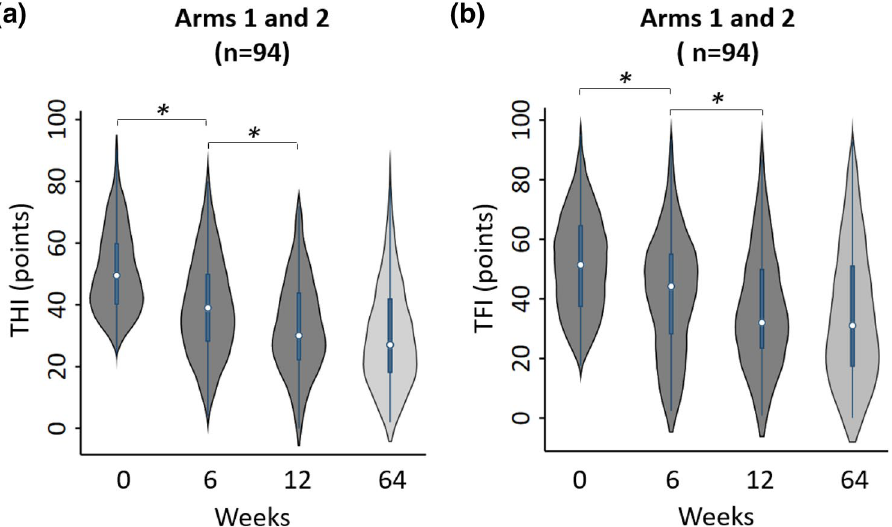
Figure 5. Additional reduction in tinnitus symptoms with adjustment of parameter settings at the midway point during treatment. Absolute THI or TFI scores (distribution of values as violin plots) are presented at different time points during the treatment period at Week 0 (baseline), Week 6 (interim), Week 12 (final) and Week 64 (12-month post-treatment) for pooled data across arm 1 and arm 2 for THI ( a ) and TFI ( b ). Data is included for participants who were treatment-compliant (≥ 18 h treatment at interim and ≥ 36 h treatment at final) and correspond to the same data shown in Fig. 4. Different stimulus combinations were implemented in the first versus second 6-week period. Asterisks correspond to significant reductions in THI or TFI scores based on a Wilcoxon signed-rank test ( P < 0.05). Significant P-values accounting for multiple comparisons based on the Bonferroni correction are labeled with asterisks in order from left to right in each plot: ( a ) P < 0.00001, P < 0.00001; ( b ) P < 0.00001, P =